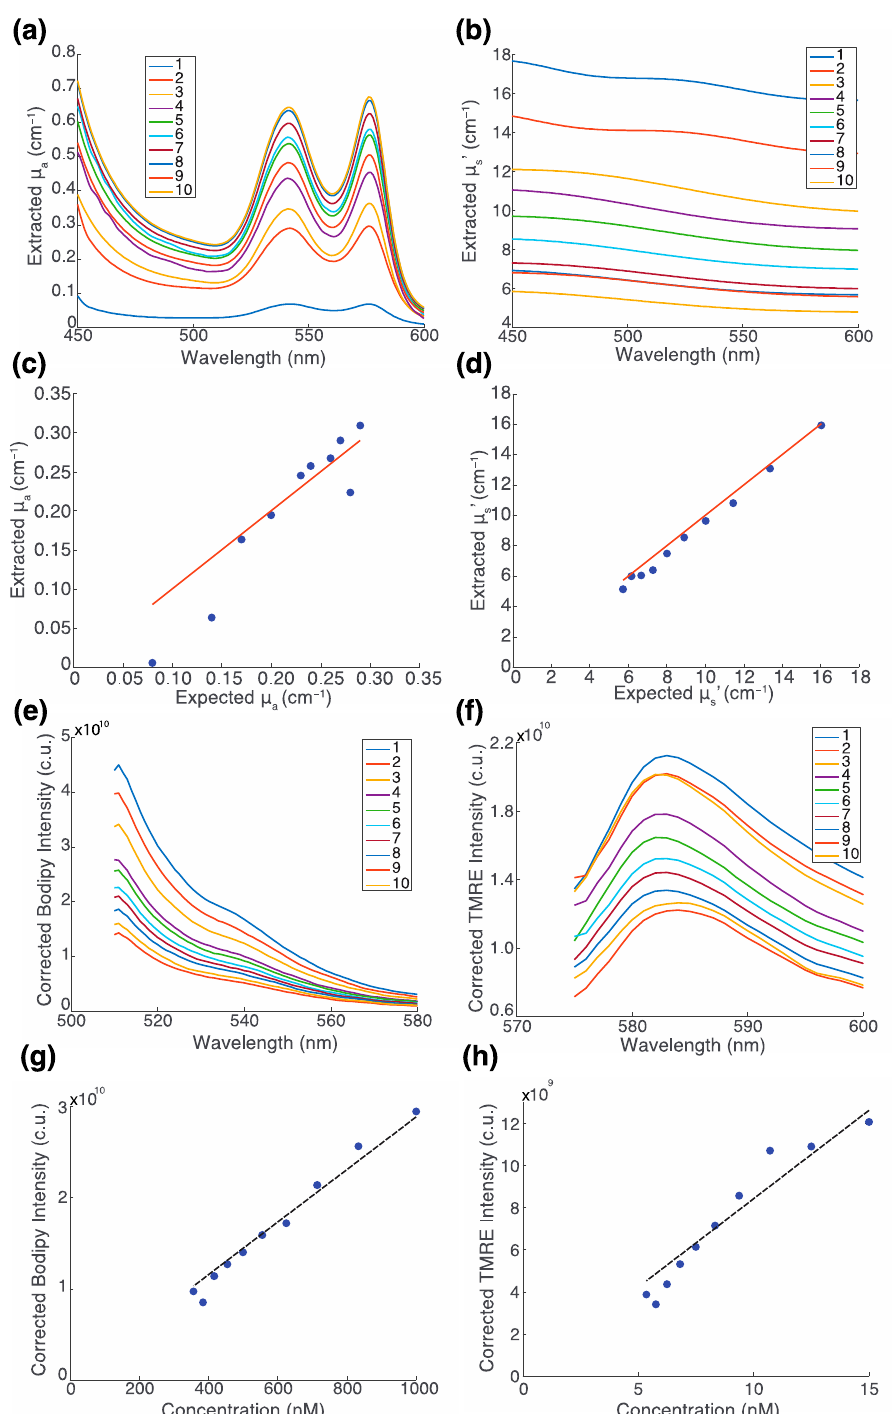
Figure 3. The fluorescence of TMRE and Bodipy FL C16 along with optical properties can be extracted from turbid phantoms. ( a ) Extracted absorption coefficient ( μ a , cm − 1 ) and ( b ) extracted reduced scattering coefficient ( μ s ’, cm − 1 ) across wavelengths 450 nm to 600 nm for each of ten phantoms. ( c ) Expected vs. extracted absorption coefficient ( μ a , cm − 1 , R 2 = 0.9116); ( d ) Expected vs. extracted reduced scattering coefficient ( μ s ’, cm − 1 , R 2 = 0.9964); the red line represents y = x. Inverted ( e ) Bodipy FL C16 and ( f ) TMRE spectra for all ten phantoms. Extracted fluorescence signal vs. concentration for ( g ) Bodipy FL C16 (R 2 = 0.9721) and ( h ) TMRE (R 2 = 0.9183). Points in ( c , d , g , h ) represent single measurements. The dashed black line in ( g , h ) represents the line of best fit passing through the origin (0,0). Intensity is reported in corrected units (c.u.).